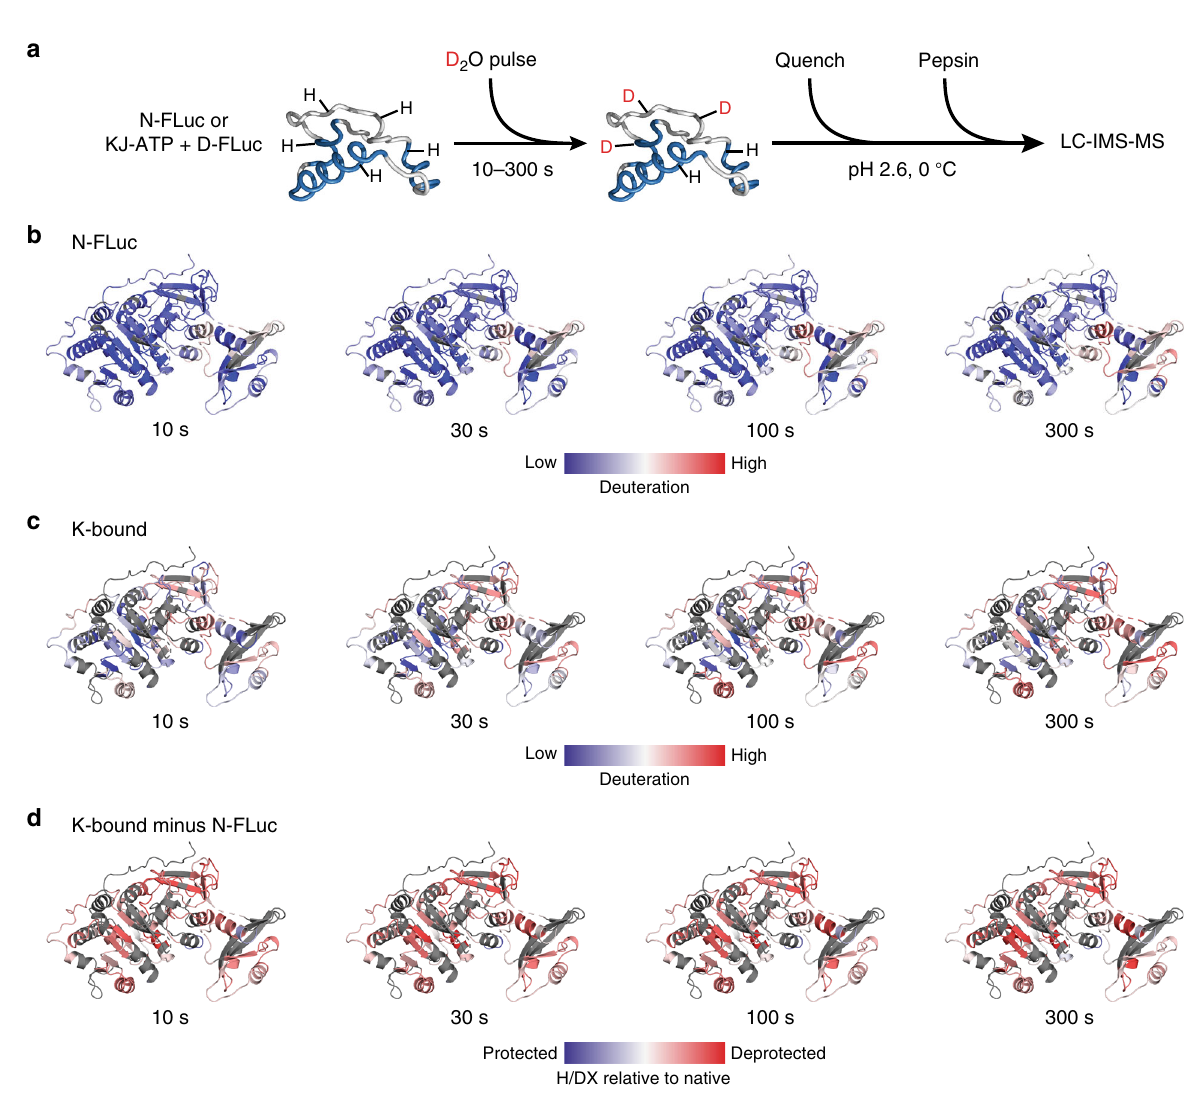
Fig. 5 Conformational dynamics of native and DnaK-bound FLuc. a Scheme of equilibrium H/DX-MS experiment. b – c , Peptide-level deuterium exchange of native FLuc (N-FLuc) ( b ) or DnaK-bound FLuc (K-bound) ( c ) after exposure to deuterium for 10-300s. Relative fractional deuterium exchange for each peptide is mapped onto the structure of FLuc (PDB ID: 1LCI) as a gradient from blue (0%) to red (75%). d Difference in deuterium exchange between DnaK-bound and N-FLuc at peptide level. Deuteration differences are scaled from blue ( − 50%) to red ( + 50%). Regions coloured red are deprotected when bound to DnaK. H/DX data are the average of three independent characteristic of the DnaK-bound state (Fig. 4e). Note that the small amount of spontaneously folded FLucNC did not shift (Fig. 4e), as KJ-ATP does not bind N-FLuc (Supplementary